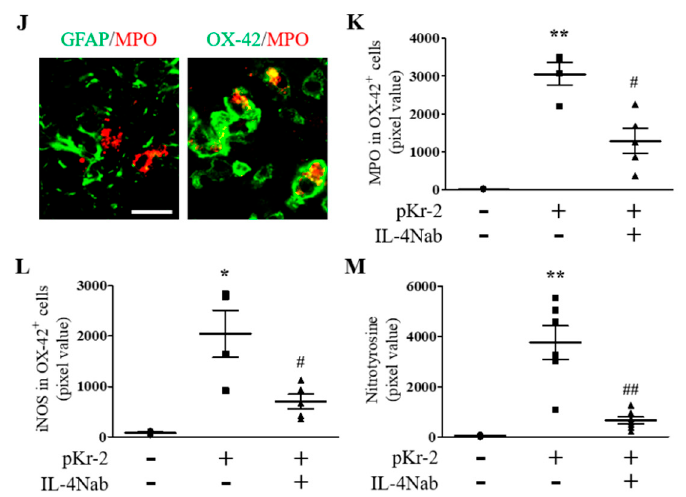
Figure 6. IL-4 modulates MPO- and iNOS-derived oxidative/nitrosative stress within activated microglia/macrophages in the CA1 layer of pKr-2-injected hippocampus in vivo. Sections ( A , D , G (PBS); B , E , H (pKr-2); C , F , I (pKr-2 + IL-4Nab)) adjacent to those used in Figure 4 were processed for immunohistochemical staining. ( A – C ) Double immunofluorescence images of myeloperoxidase (MPO; red) and OX-42 (green) for microglia/macrophages/neutrophils and both images are merged (yellow) in the CA1 layer of hippocampus. Scale bar, 20 μ m. ( D – F ) Double immunofluorescence images of inducible nitric oxide synthase (iNOS; red) and OX-42 (green) for microglia/macrophages/neutrophils and both images are merged (yellow) in the CA1 layer of hippocampus. Scale bar, 20 μ m. ( G – I ) Immunofluorescence images of nitrotyrosine (green) to detect nitrosative damages in the CA1 layer of hippocampus. Nuclei were counterstained with DAPI (blue). Scale bar, 40 μ m. ( J ) Double immunofluorescence images of GFAP (green, left panel) for astrocytes and MPO (red, left panel) or OX-42 (green, right panel) for microglia/macrophages/neutrophils and MPO (red, both panel) and both images are merged (yellow) in the CA1 layer of hippocampus. Scale bar, 20 μ m. ( K ) Quantification of MPO expression in OX-42 + microglia/macrophages/neutrophils. ** p < 0.001, significantly different from PBS (control). # p < 0.01, significantly different from pKr-2. mean ± SEM; n = 4 to 5 in each group, ANOVA and Newman–Keuls analysis. ( L ) Quantification of iNOS expression in OX-42 + microglia/macrophages/neutrophils. * p < 0.01, significantly different from PBS (control). # p < 0.01, significantly different from pKr-2. mean ± SEM; n = 4 to 5 in each group, ANOVA and Newman–Keuls analysis. ( M ) Quantification of nitrotyrosine expression. ** p < 0.001, significantly different from PBS (control). ## p < 0.001, significantly different from pKr-2. mean ± SEM; n = 4 to 5 in each group, ANOVA and Newman–Keuls analysis. Dotted lines indicate the CA1 layer of the hippocampus.